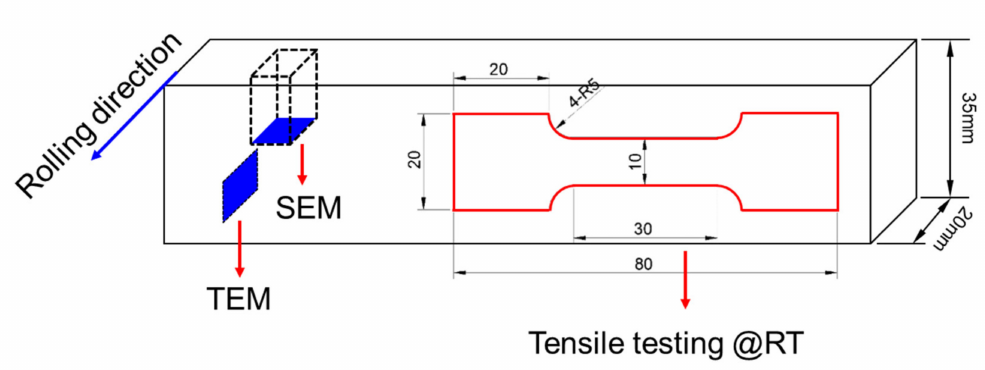
Figure 1. Sample sizes and the schematic diagrams for microstructure observations and tensile